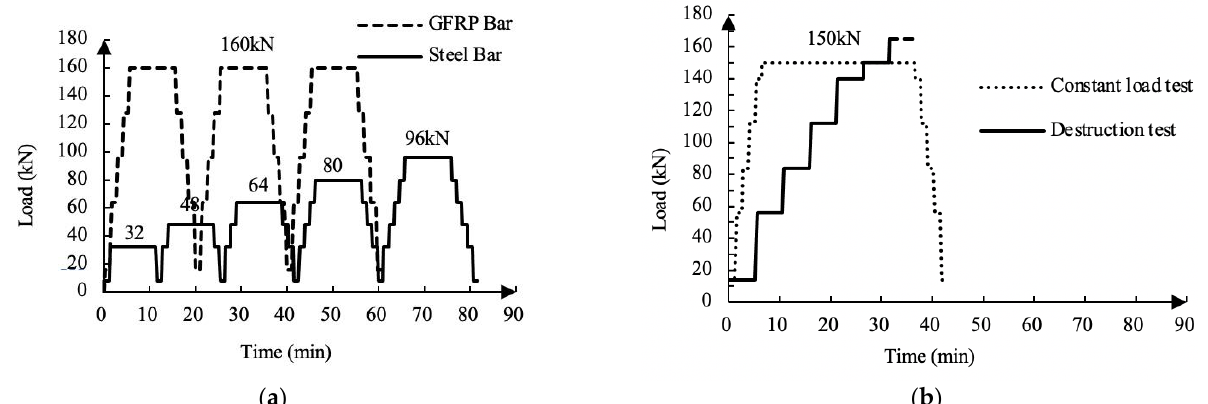
Figure 7. Test loading curve of the steel and GFRP bar. ( a ) Loading curve of the cyclic test ( b ) Loading curve of the constant load test and destruction test.